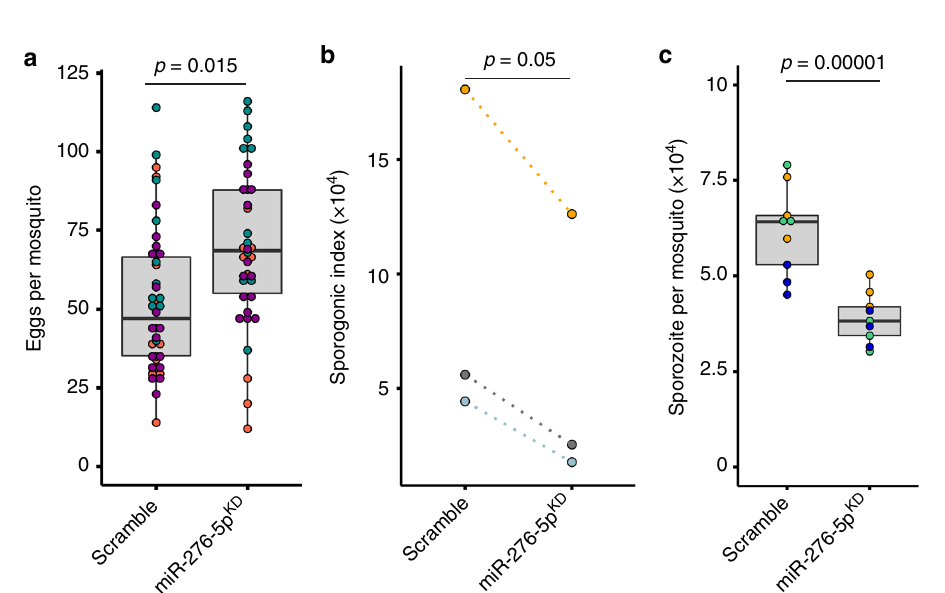
Fig. 4 Effects of miR-276 silencing on mosquito fertility and P. falciparum sporogonic development. a Egg laying rates (fertility) of individual females injected with miR-276 (miR-276 KD ) or control antagomir (scramble) after a blood meal. Boxplots show the median with fi rst and third quartile, whiskers depict min and max values. Each dot represents one mosquito and dot colors indicate independent experiments ( N = 3, Supplementary Table 3). b Females injected with miR-276 (miR-276 KD ) or control (scramble) antagomir were infected with P. falciparum . At day 11 post infection, oocyst number and size were measured. The median of P. falciparum oocysts per midgut and mean of P. falciparum oocyst size per experiment were multiplied to generate a sporogonic index ( N = 3, Supplementary Table 3). c The numbers of the salivary gland sporozoites per mosquito were quanti fi ed on day 14 post infection. Boxplots show the median with fi rst and third quartile, whiskers depict min and max values. Colors show replicates of each independent experiment. Statistically signi fi cant differences are indicated by p -values above the horizontal lines deduced by one-way ANOVA and Tukey ’ s post-hoc test ( N = 3, Supplementary Table 3), N = number of independent